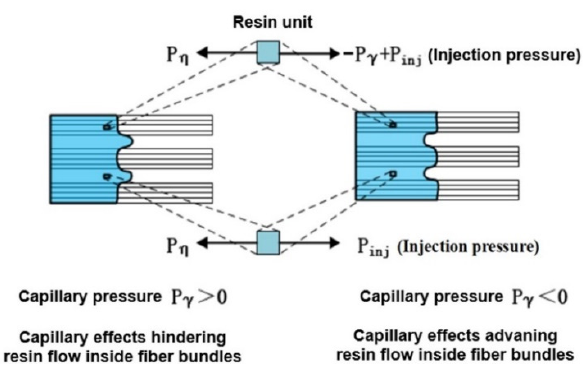
Figure 1. Formation mechanism of dual-scale flow in resin infiltration process.